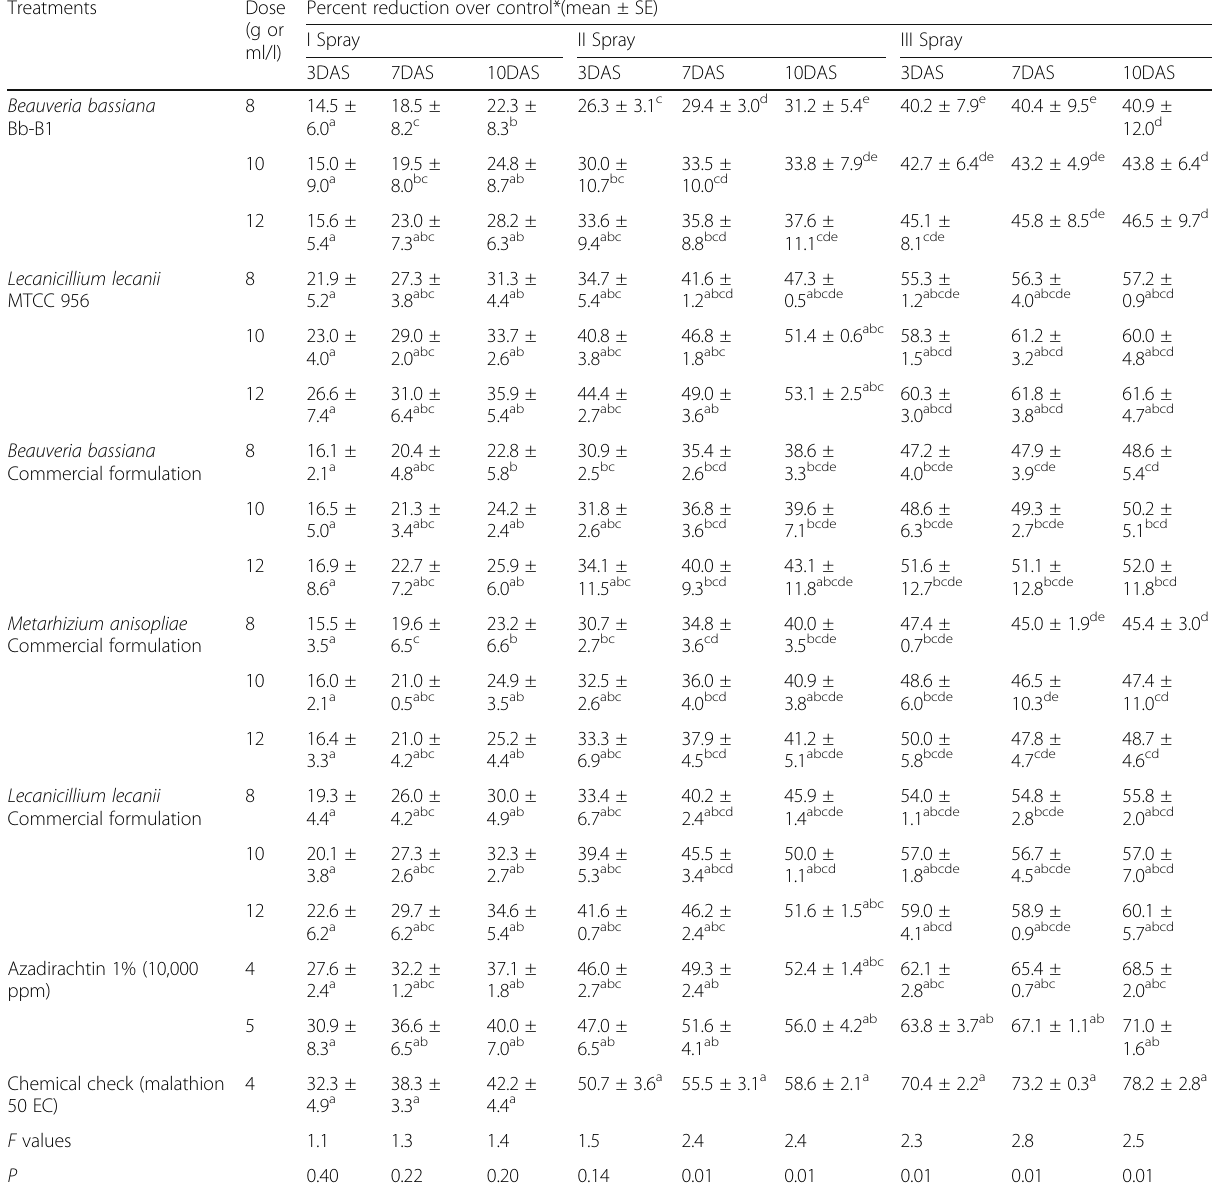
Table 4 Percentage reduction of whitefly, Bemisia tabaci , on capsicum plant treated with indigenous and commercial bioformulations under protected cultivation (2017, 2018)